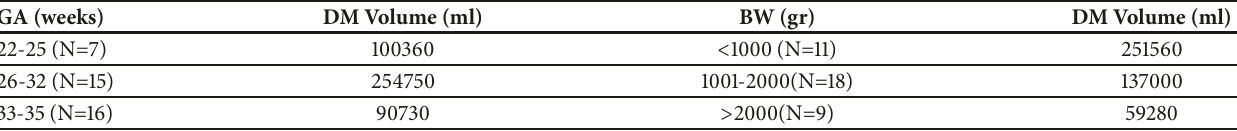
Table 1: Total donor milk (ml) according to gestational age and birth weight categories.